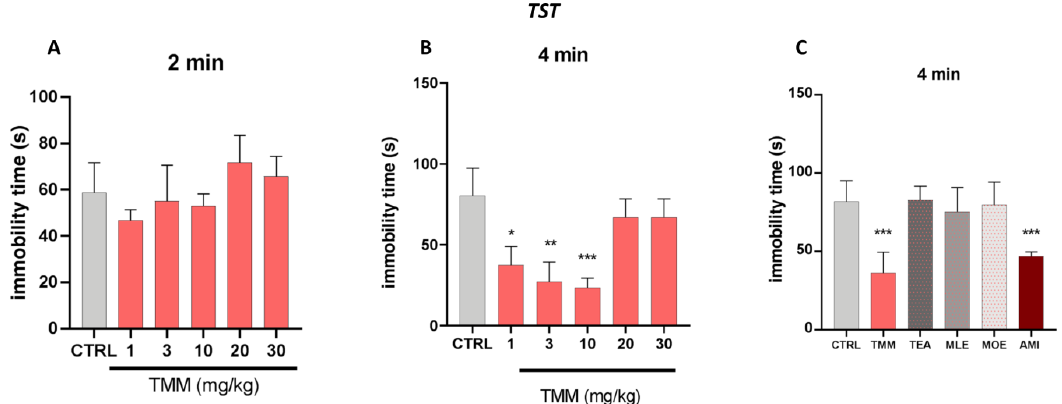
Figure 3. Evaluation of the antidepressant activity of TMM and its constituents. Dose–response curve obtained with different concentrations of TMM in the tail suspension test (TST), in the first 2 min ( A ) and in the last 4 min ( B ). Effect of TMM (10 mg/kg), TEA (2.5 mg/kg), MLE (0.625 mg/kg), and MOE (0.25 mg/kg) in the TST in the last 4 min ( C ). Amitriptyline (AMI) was used as an antidepressant reference drug. *** p < 0.001, ** p < 0.01, * p < 0.05 vs. CTRL.